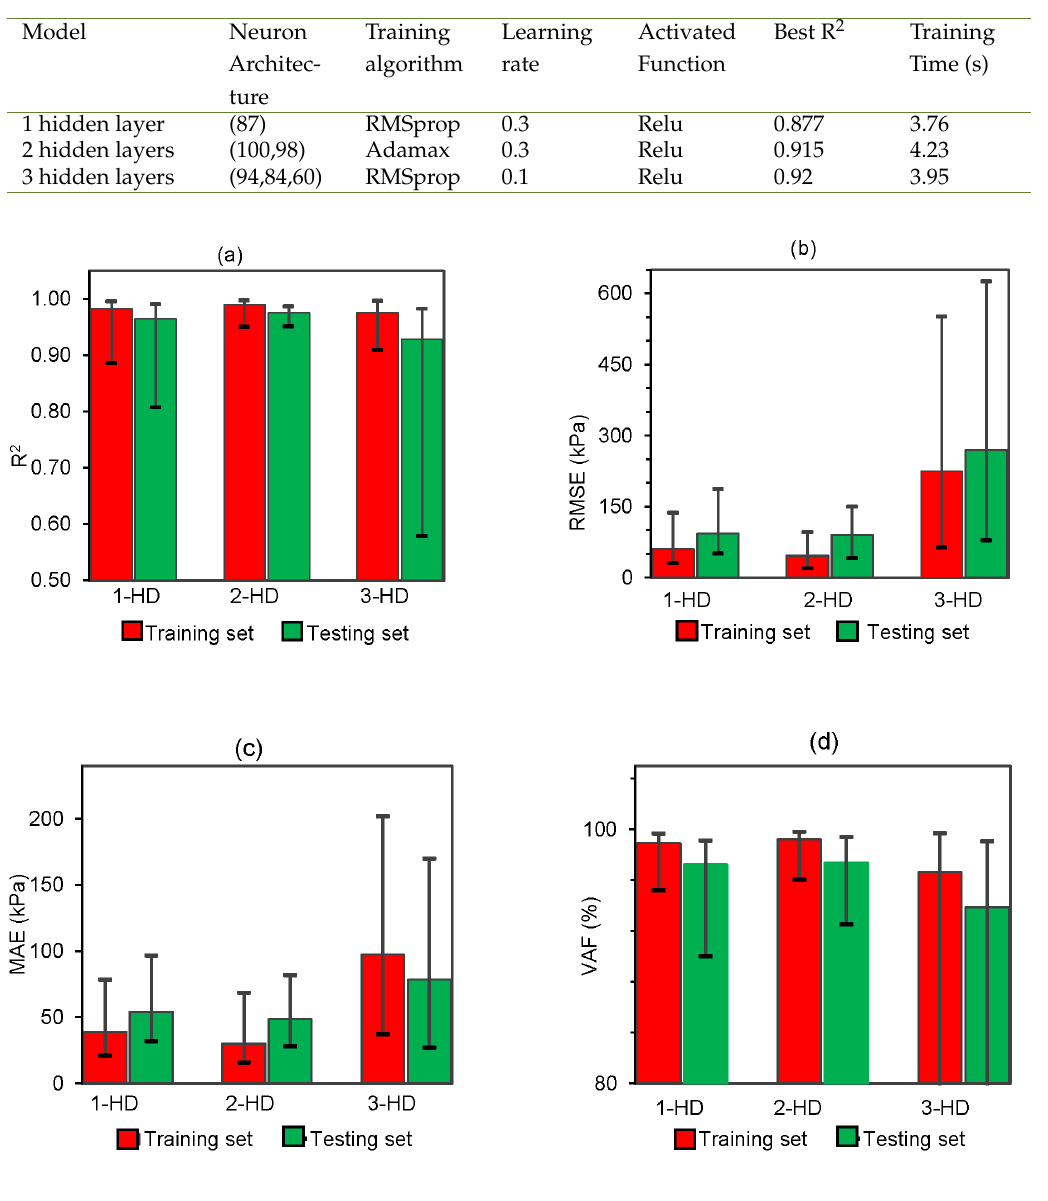
Fig. 7. Performance of the DNN models using criteria: R 2 (a) and RMSE (b) (HD: Hidden